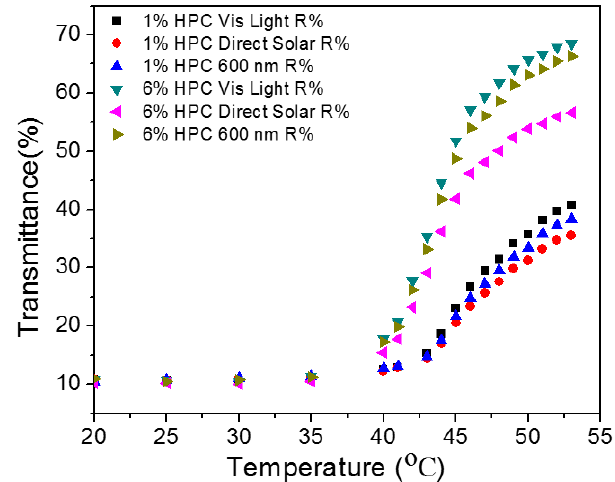
Figure 9. Measured reflectance for aqueous 1 wt. % and 6 wt. % HPC at 600 nm, Vis Light T% (averaged over 430 nm to 780 nm) and Direct Solar T% (averaged over 440 nm to 950 nm).